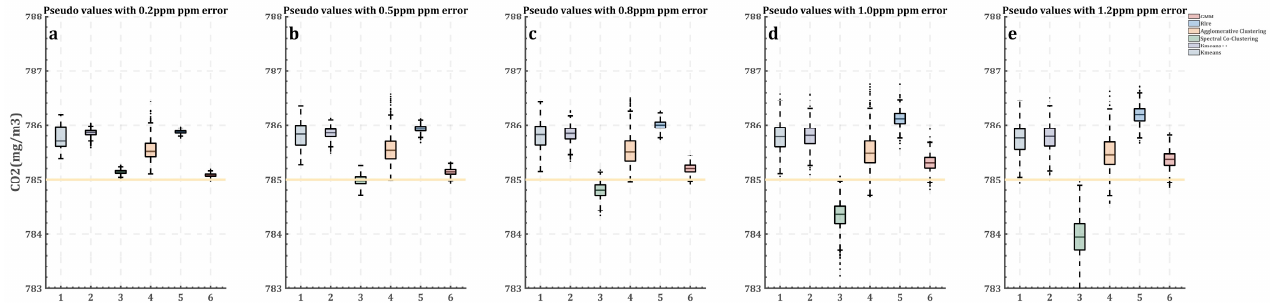
Figure 11. Background concentration estimates in pseudo measurements with three peaks.